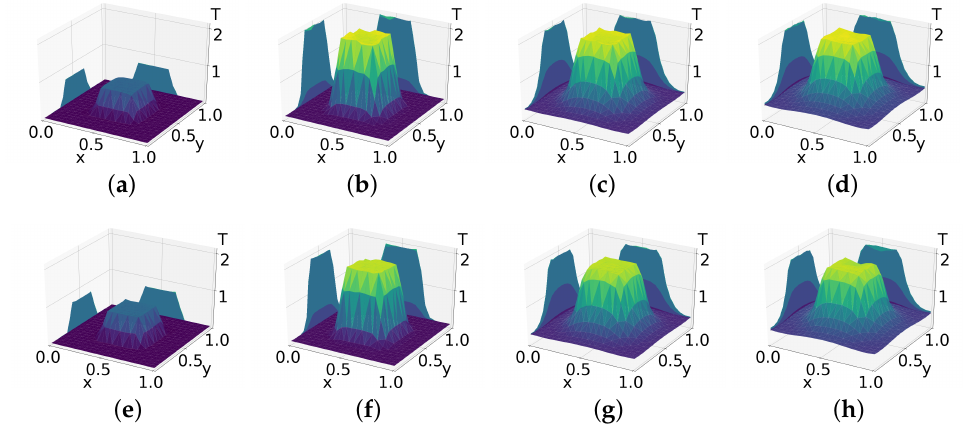
( t , x ) , ξ , t , x )] on the first prediction horizon by ( 0, H ]